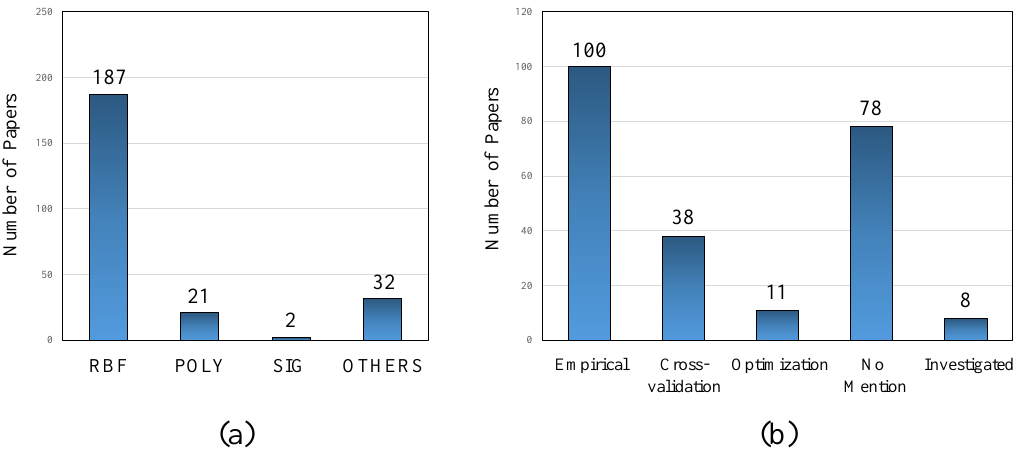
Figure 8. ( a ) Number of papers that cited the use of which kernel functions; ( b ) Number of papers that cited the use of which kernel parameter selection routes. Note: Papers can appear in more than one column, hence, the numbers will not add to 230 (the total number of reviewed